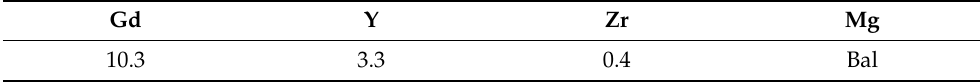
Table 1. Chemical composition